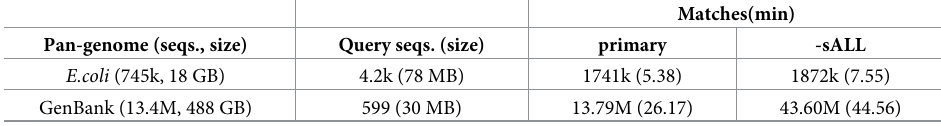
Table 7. Aligning bacterial sequences to a compressed index with BLAST (blastn).